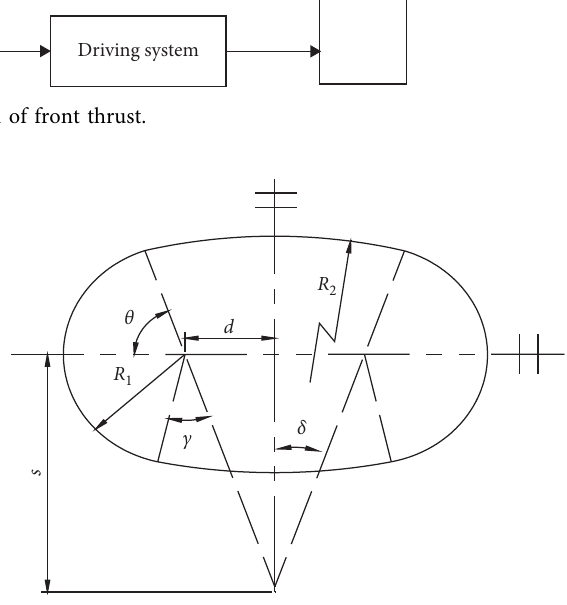
Figure 5: Cross-sectional shape of quasirectangular